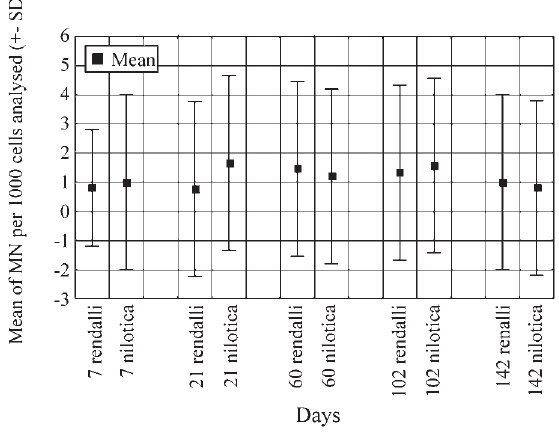
Figure 1 - Mean micronucleus frequencies in O. niloticus and T. rendalli after 142 days of maintenance in the wastewater treatment tanks. MN fre- quencies did not differ statistically from the fish living in Lake Paranoá (Mann-Whitney U test, p >